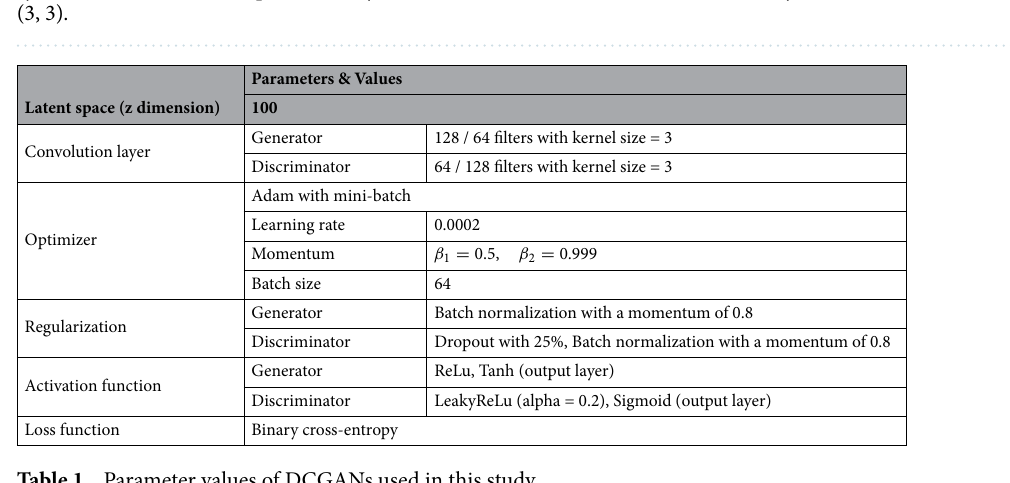
Table 1. Parameter values of DCGANs used in this